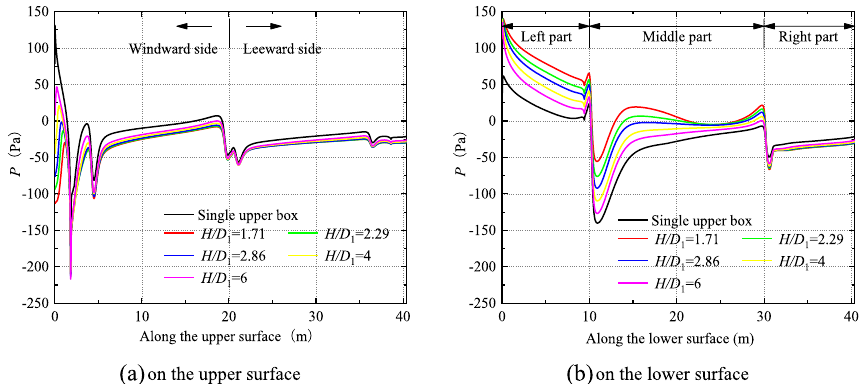
Fig. 10 Distributions of the static pressure on the upper